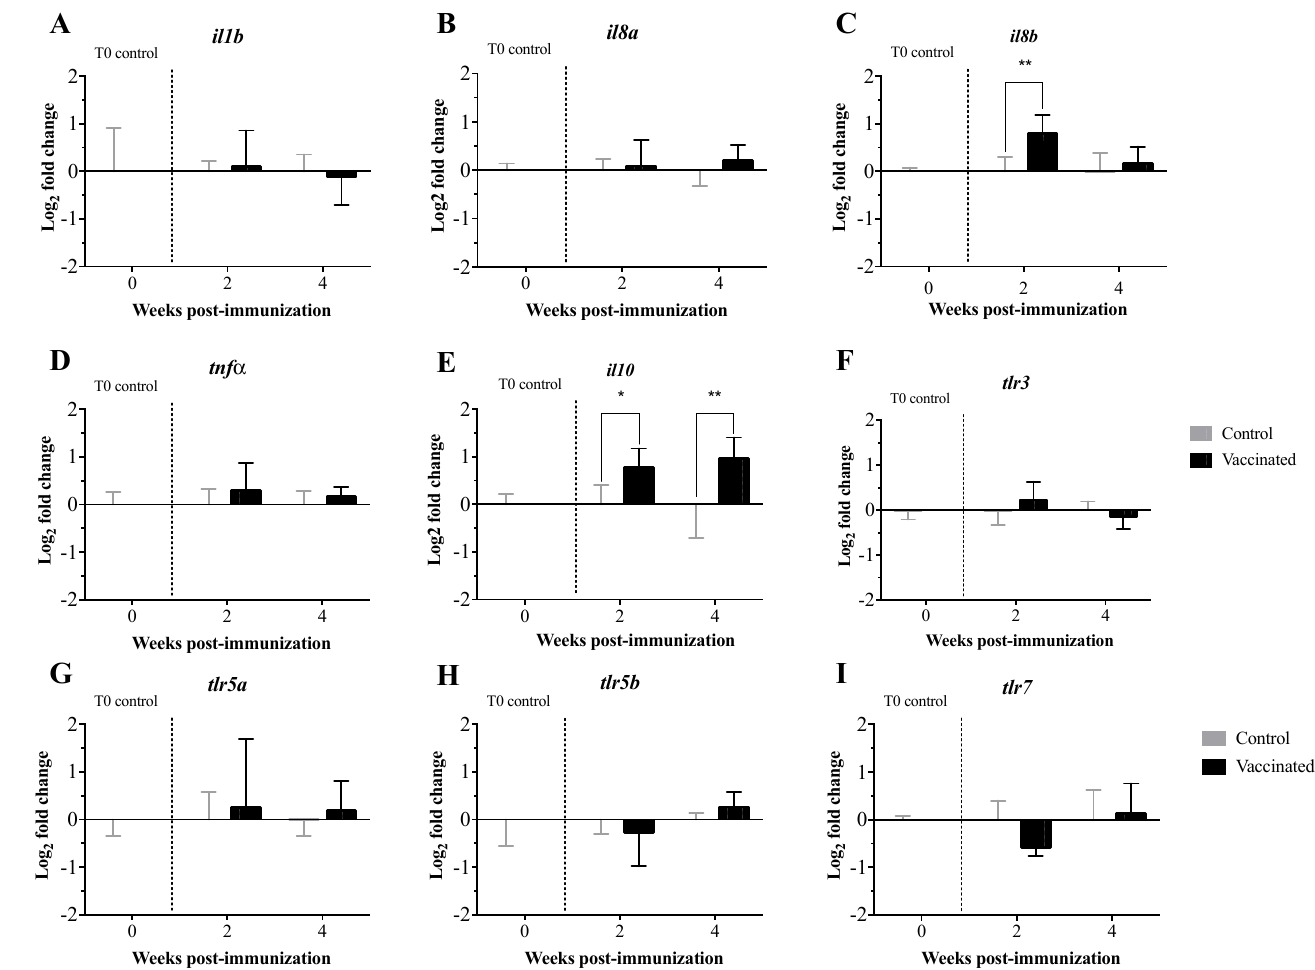
Figure 4. Transcript expression levels of cytokines and toll-like receptors in lumpfish larvae orally immunized with the V. anguillarum bacterin bio-encapsulated in A. salina nauplii. ( A – E ). Cytokines; ( F – I ). Toll-like receptors. Transcript expression levels were assessed pre-immunization (T0 control, n = 3 individual pools of 10 larvae each), 2 wpi ( n = 3 pools of 10 larvae each), and 4 wpi ( n = 3 pools of 5 larvae each). Time point controls post-mock immunization were collected in a similar fashion at 2 and 4 wpi. Relative expression was calculated using the 2 ( − ∆∆ Ct) method and normalized using log 2 ; etif3d and rpl32 were used as endogenous controls. A two-way ANOVA test, followed by the Sidak multiple comparisons post hoc test was used to assess significant differences between the treatments (control and vaccinated) at each individual time point. Asterisks (*) represent significant differences (* p < 0.05, ** p < 0.01).